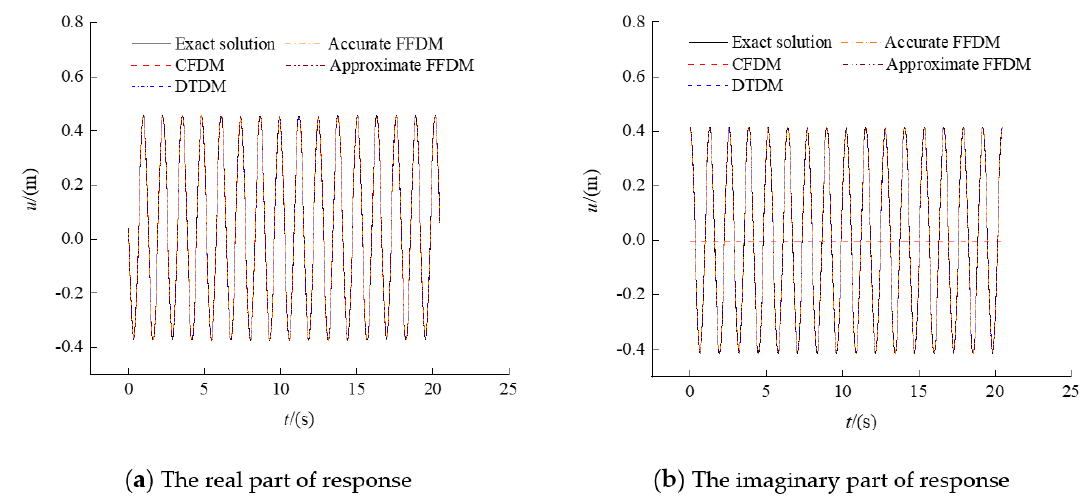
Figure 5. Displacement response time history of different methods under non-zero mean cosine force ( θ / ω = 1). Table 2. The relative errors of the amplitude of displacements under a non-zero mean value force (%).